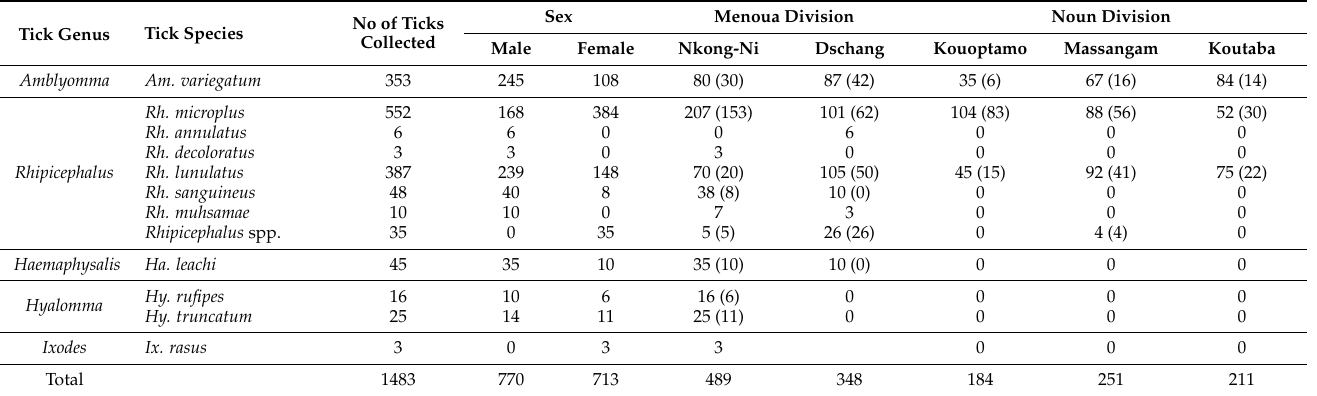
Table 2. Tick species and numbers of tick specimens collected from cattle in the five study sites in Western Highlands of Cameroon. For each site, the number of female tick specimens is indicated in parentheses.